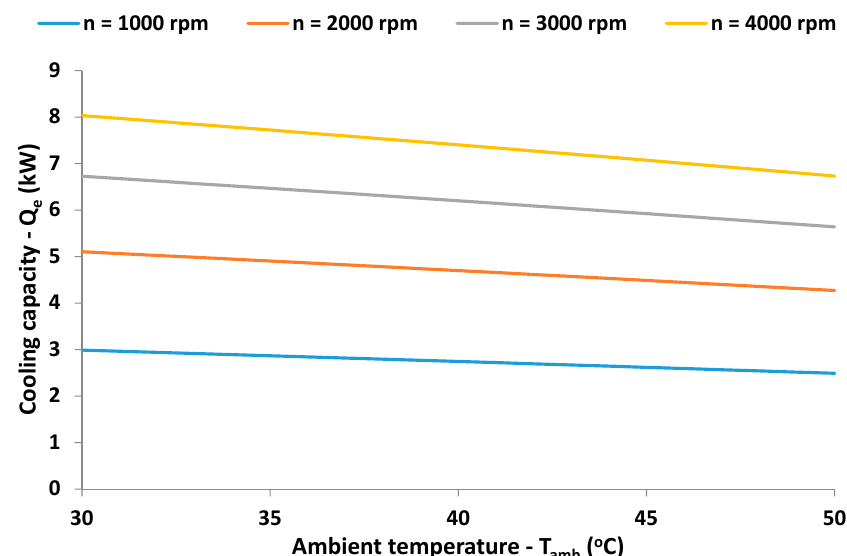
Figure 7. Cooling capacity for different ambient temperatures and rotational speeds ( T ind = 25 °C).